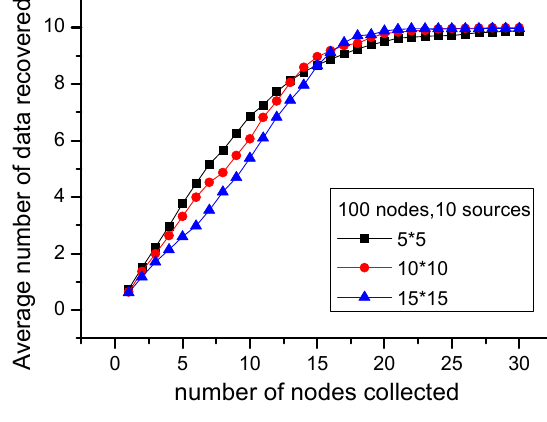
Figure 14. Data recovered with different network